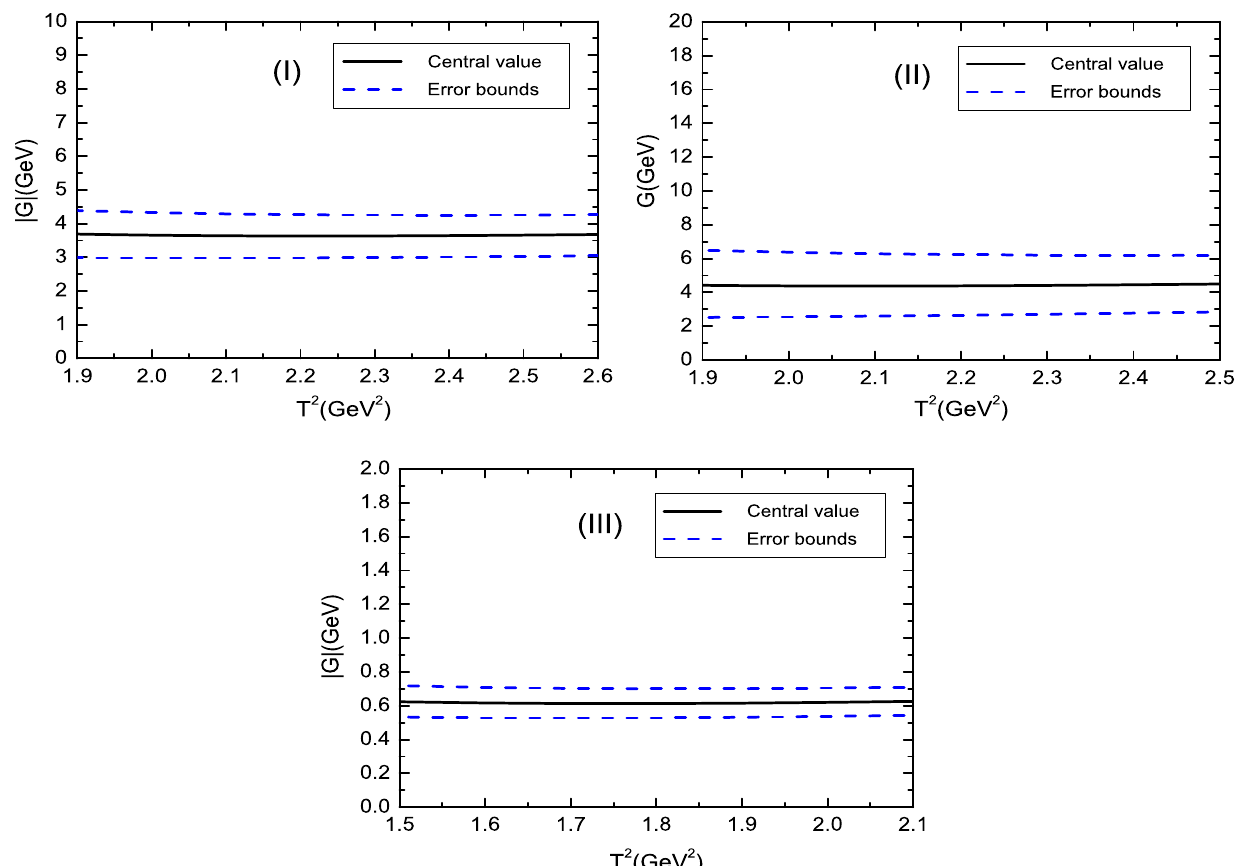
Fig. 1 The hadronic coupling constants G Z